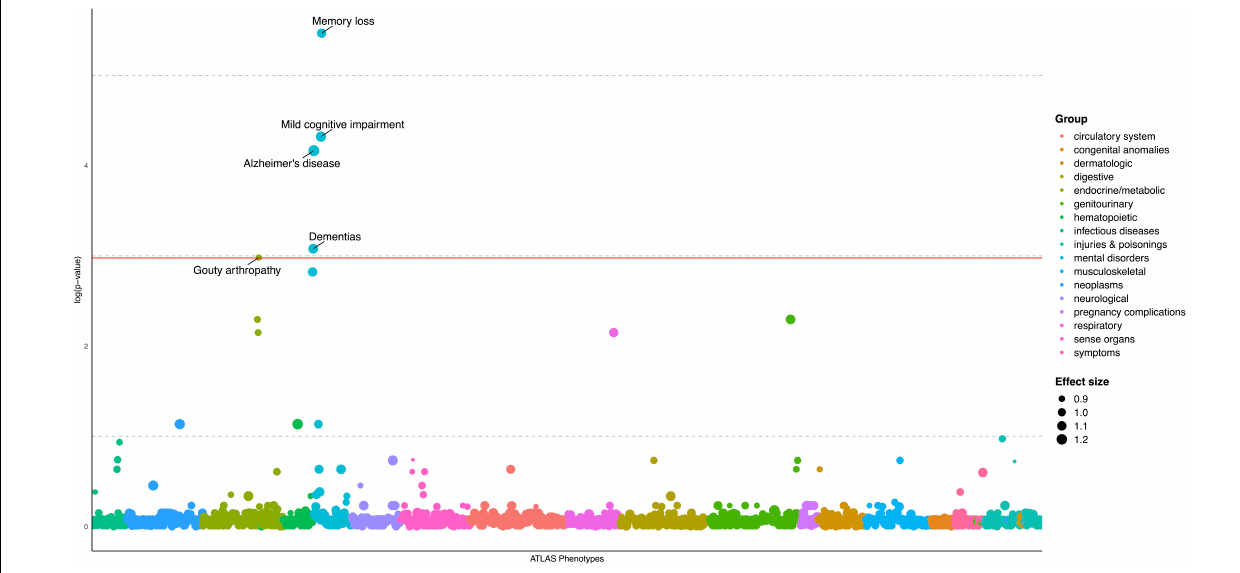
FIGURE 1 | PheWAS plot for Alzheimer’s disease polygenic risk score, European ancestry sample ( N = 19,934). 1515 traits (number of cases/controls ≥ 50) are grouped into 17 color-coded categories as shown on the horizontal axis; the p -values for testing the associations of PRS with the traits were adjusted by FDR and transformed to minus natural logarithms, shown on the vertical axis. The size of the dot refers to effect size (OR) of AD PRS on traits. All values were based on results from multivariable logistic regression analyses, in which “no disease/symptom” was used as the reference group, adjusted for age, sex, and first five PCs. The solid horizontal line for adjusted p = 0.05 cutoff.